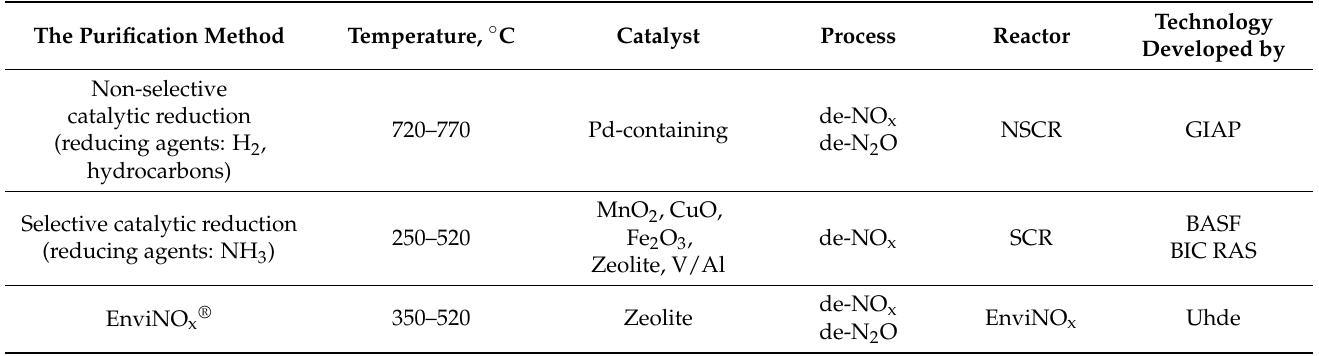
Table 1. Methods of tail-gas